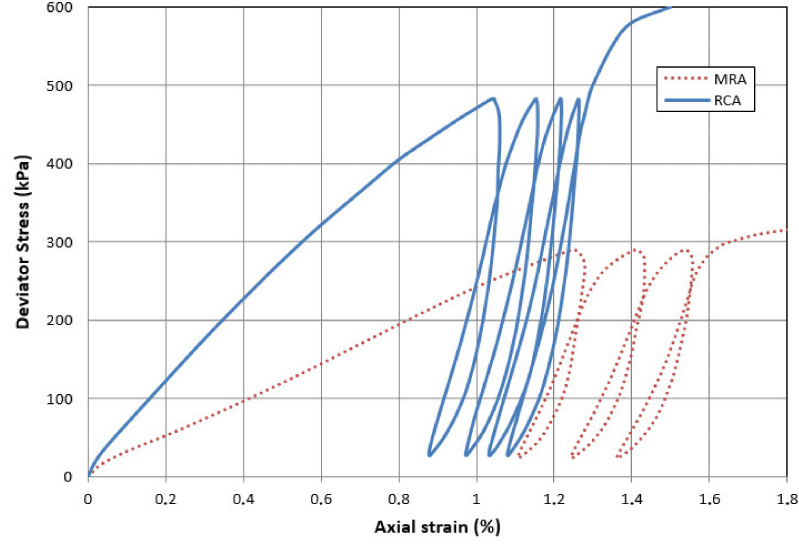
Figure 5. Strain–stress curves.